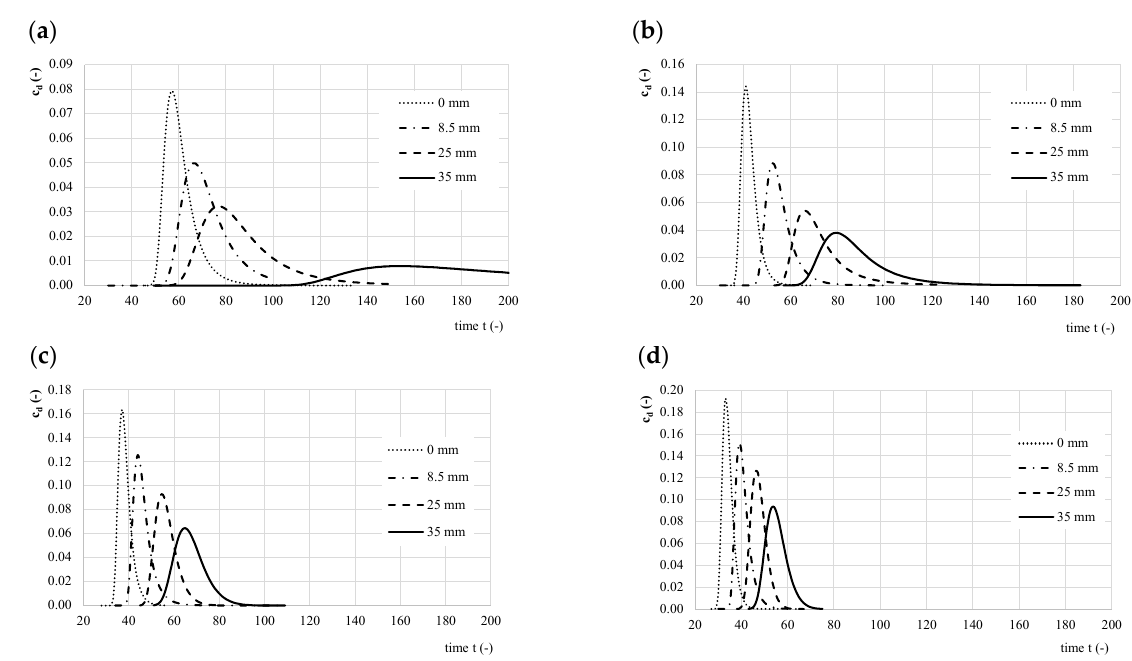
Figure 10. Results of tracer experiments—mass normalised concentration distributions in time, time is without normalisation. The particular image tagging ( a – d ) corresponds with the experiment groups in Table 2.